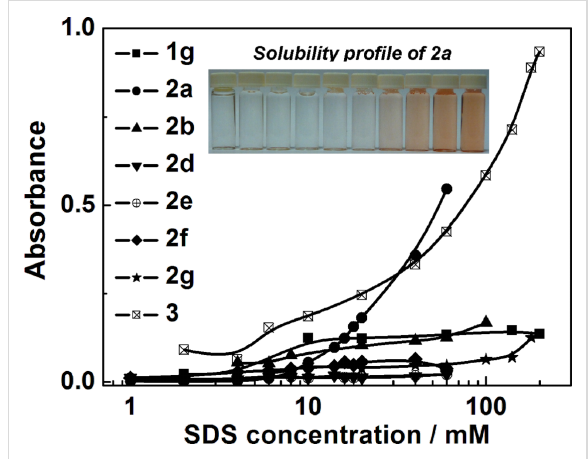
Figure 5: Absorbance of 2a , 2b , 2d–g at λ max ≈ 395 nm and 1g , 3 at λ max = 300 nm in aqueous micellar SDS solution; 25 °C, optical path 1 cm and solubility profile solution of SDS in the presence of 2a on concentration of SDS, c SDS = 2–80 mM, 25